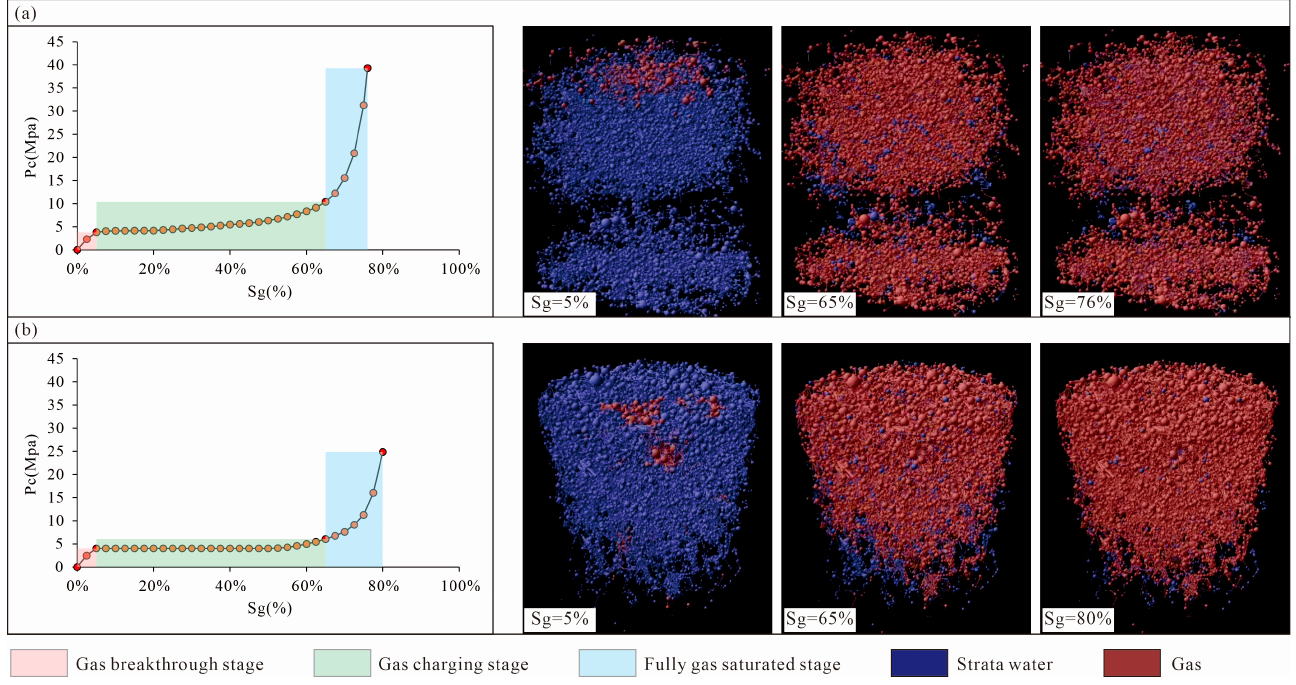
Figure 12. Digital simulation of gas charging: ( a ) sample from the Lower Shihezi Formation, depth of 3114.9 m in Well J57, medium-grained sandstone, porosity = 8.7%, permeability = 0.466 × 10 − 3 μ m 2 ; and ( b ) sample from the Lower Shihezi Formation, depth of 3035.35 m in Well J110, gravel-bearing coarse-grained sandstone, porosity = 11.1%, permeability = 1.15 × 10 − 3 μ m 2 . Abbreviations: Pc: digital simulation pressure; Sg: gas saturation.